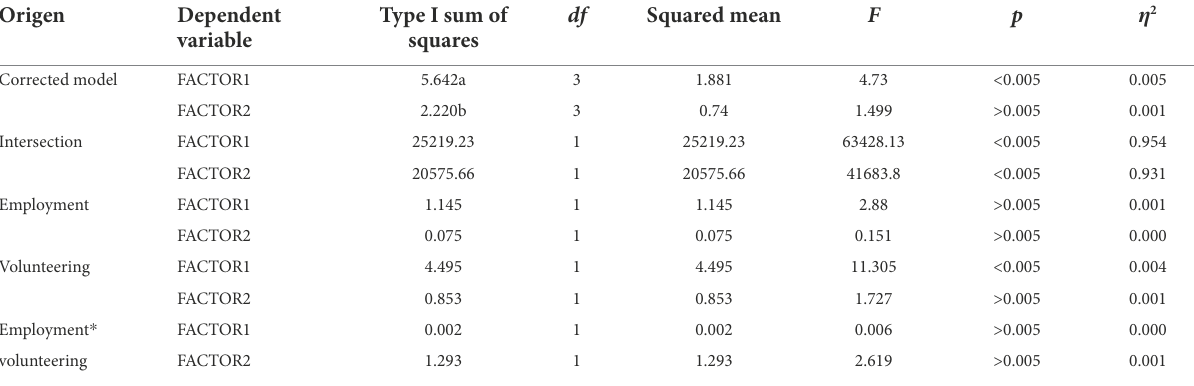
TABLE 2 Analysis of variance (ANOVA) and effect size ( η 2 ) results for the sums of aggregated scales pertaining to future work skills, as a function of volunteering and